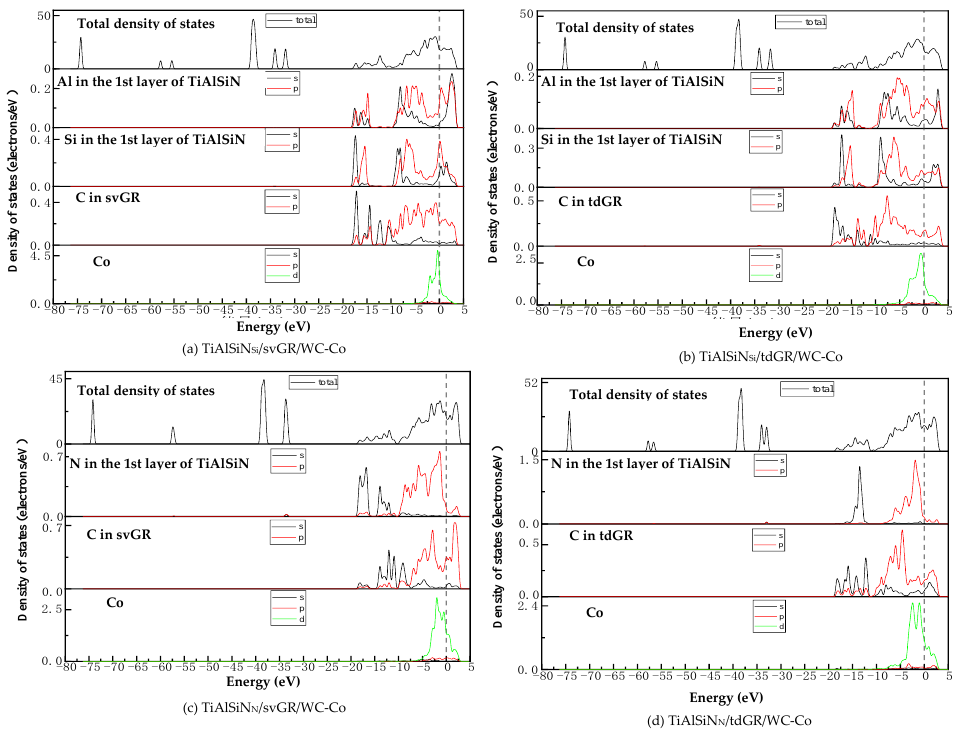
Figure 23. TDOS and PDOS of the interface models with the coating/matrix interface doped with defective graphene.